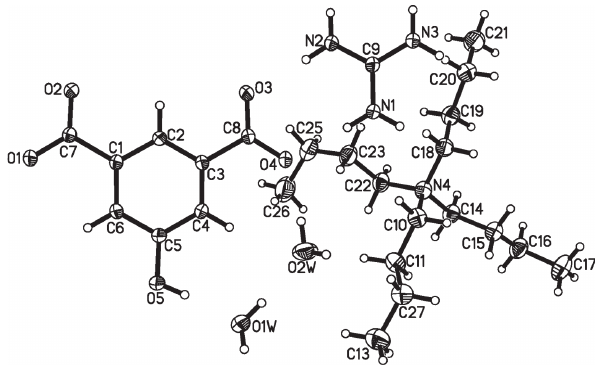
Table 2: Fractional atomic coordinates and isotropic or equivalent isotropic displacement parameters (Å 2